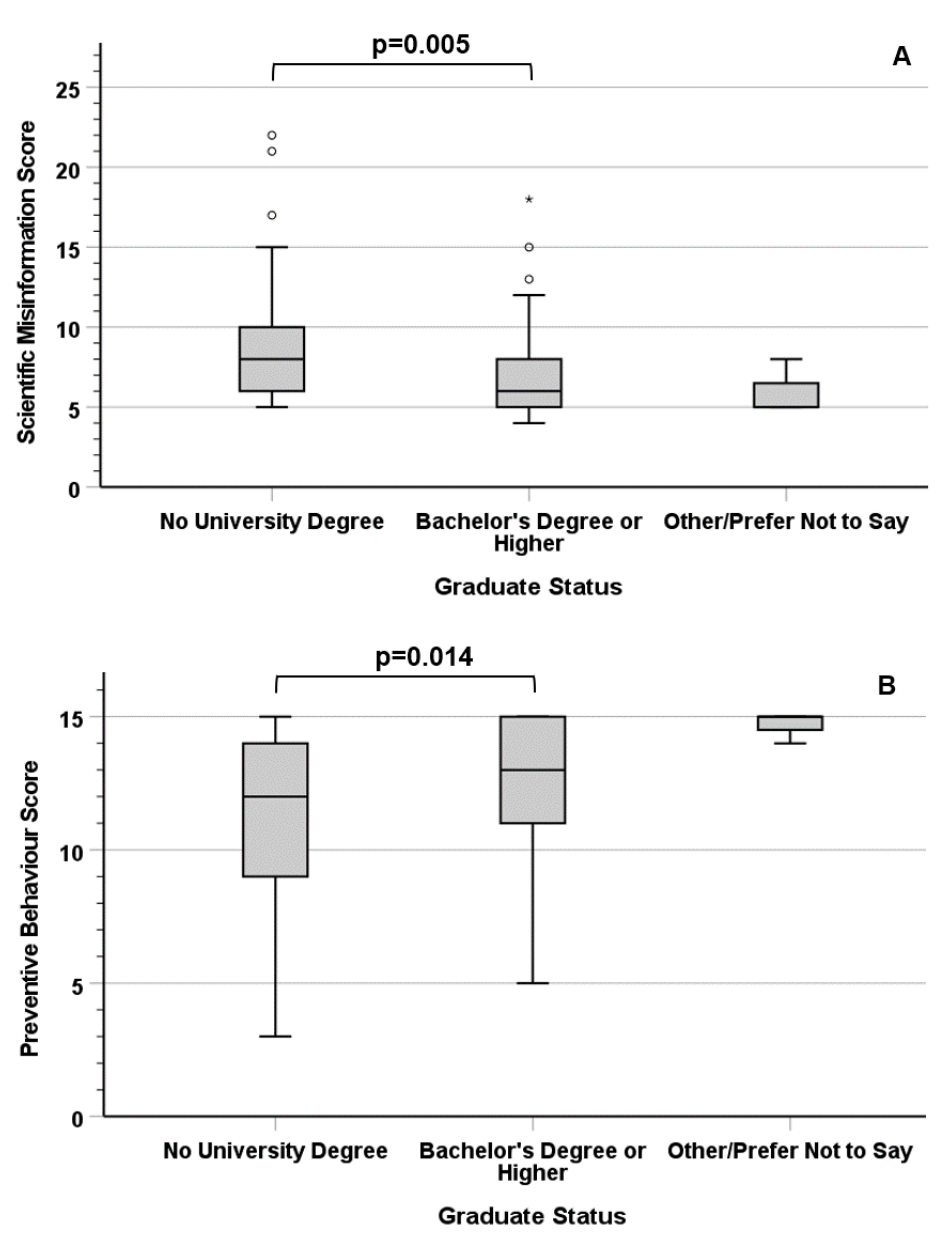
Figure 2. Association between the participants’ graduate status and their Scientific Misinformation